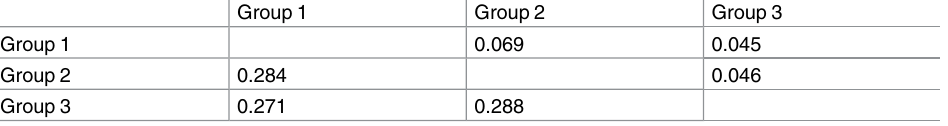
Table 3. Genetic distance (Downward Diagonal) and pairwise F st (Upward Diagonal) among the three groups inferred through structure